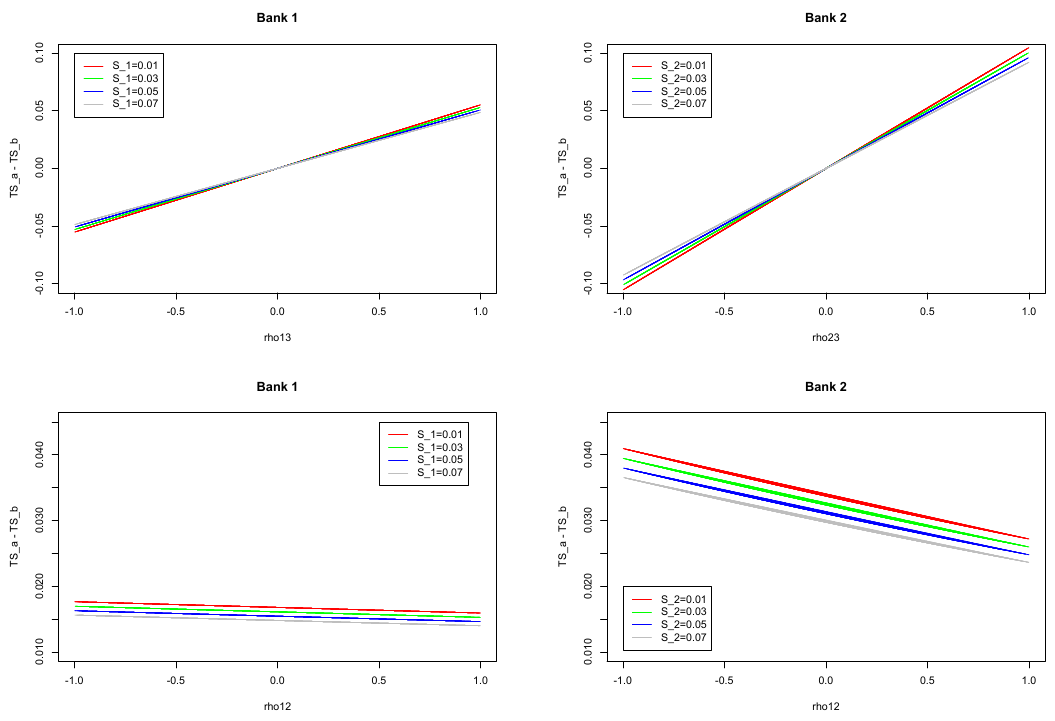
Figure 3. Changes in TS ’s as functions of partial correlations, stylized banking system. Notes: Monte Carlo simulated differences between the total spreads in case of liquidation (Scenario (a)) and private intervention (Scenario (b)) for Bank 1 ( left ) and Bank 2 ( right ), plotted as functions of µ ρ µ ρ (top-right), and µ ρ (bottom). The stronger the correlation with the troubled bank, the safer the 23 12 banks in the case of private intervention; for the small bank (Bank 2), however, this effect is a decreasing function of the partial correlation coefficient with the other safe